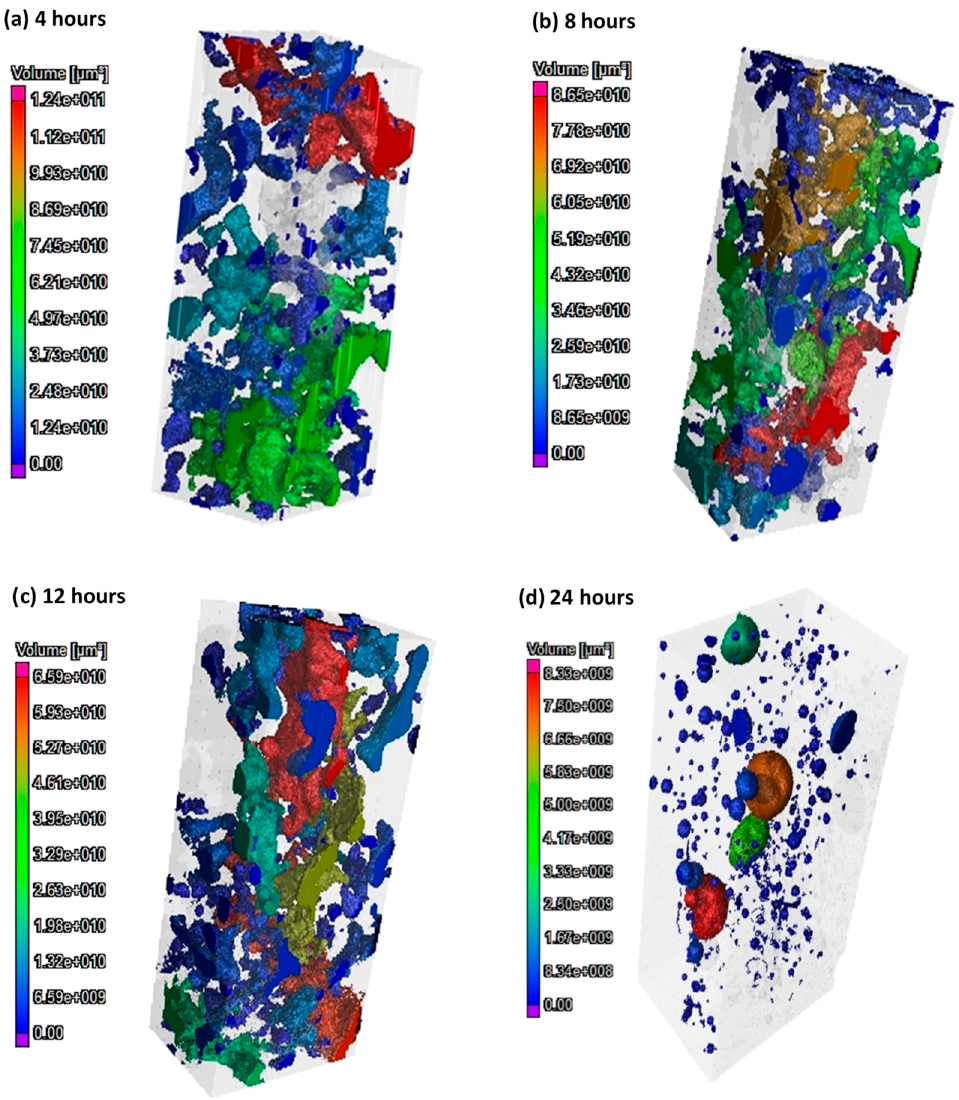
Figure 10. Pore interconnectivity and pore volume distribution of 100 mm geopolymer concrete specimen, 4–24 h.